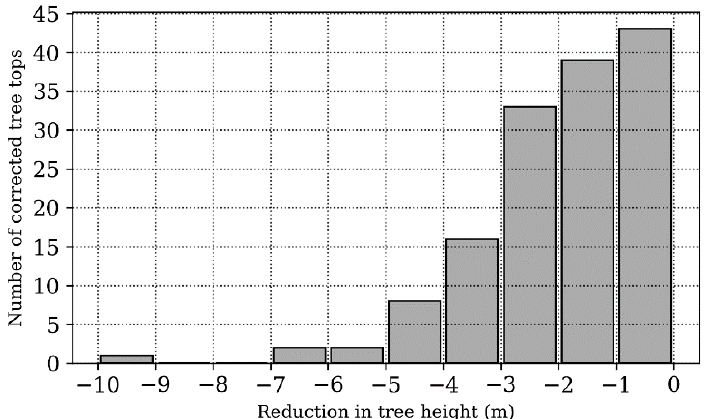
Figure 6. Effect of the automated tree top correction method on the estimated tree top height. Trees situated on steep slopes or overhanging a cliff edge typically have their top height overestimated due to the terrain normalization of the DSM. Most tree tops are reduced by 1 to 4.